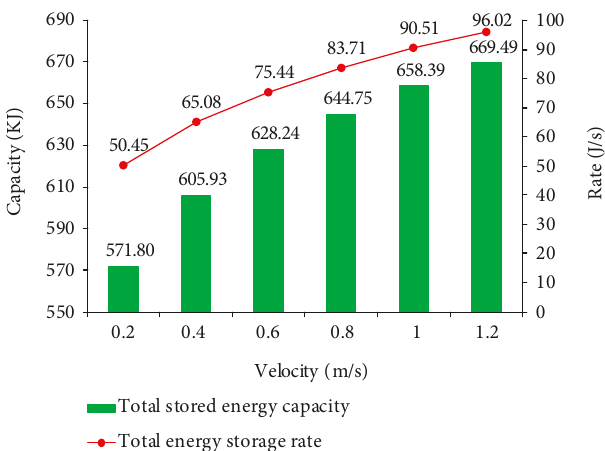
Figure 11: E ff ects of inlet velocity of HTF on the total stored energy capacity and energy storage